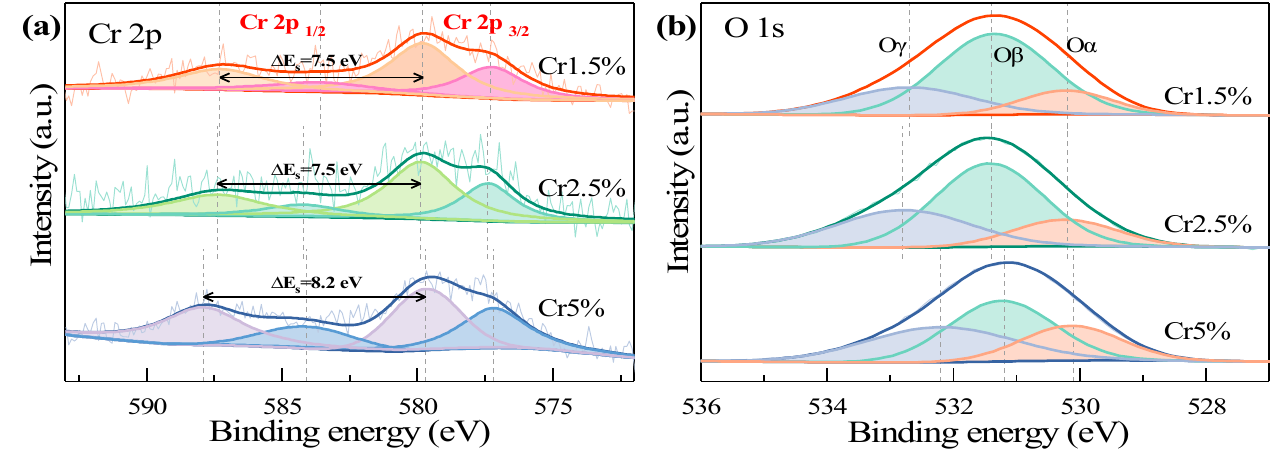
Figure 4. The Cr 2p and O 1s spectra of the Cr1.5~5% catalysts. ( a ) Cr 2p; ( b ) O 1s.